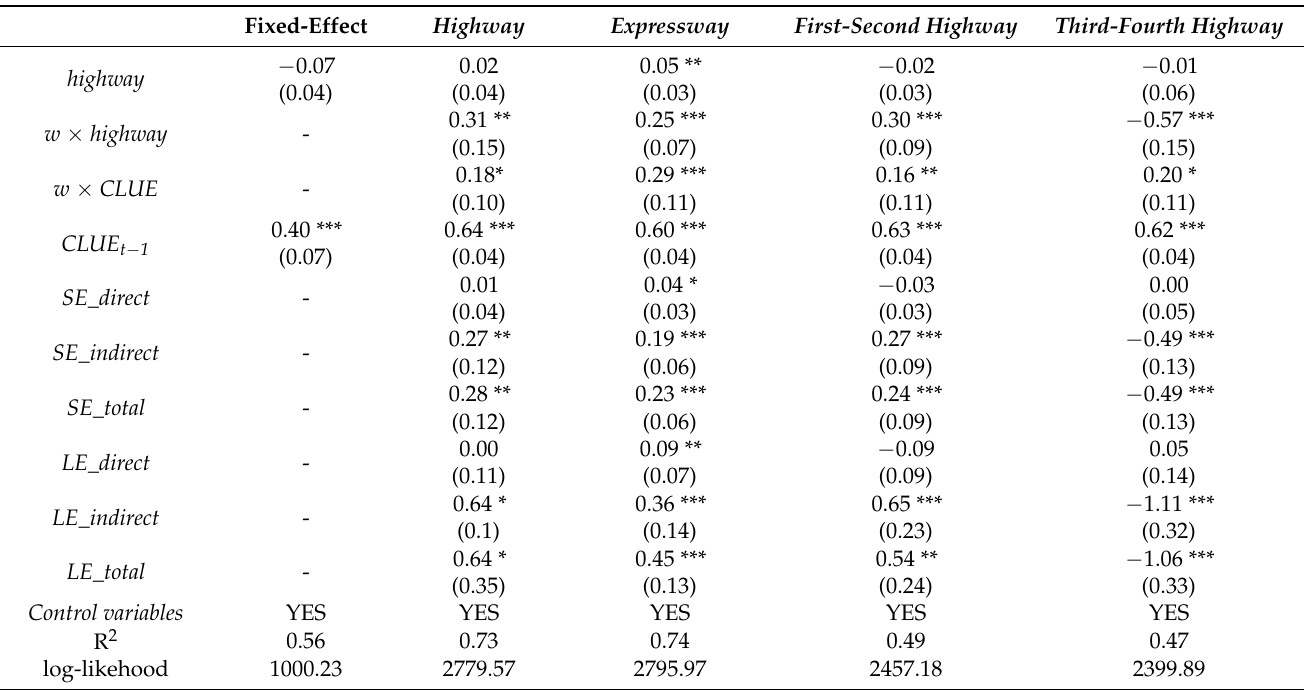
Table 5. The regression results of dynamic spatial Durbin